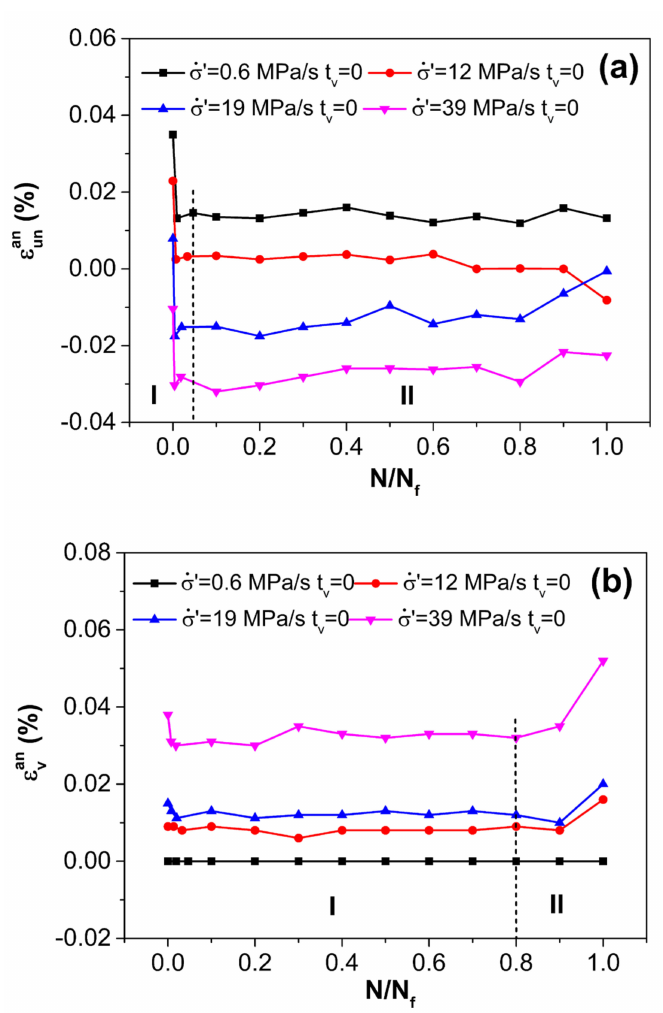
Figure 8. Evolutions of the anelastic recovery strain during the entire life for di ff erent unloading rates: ( a ) anelastic recovery strain of the unloading stage, ε an un , and ( b ) anelastic recovery strain near valley stress, ε an v